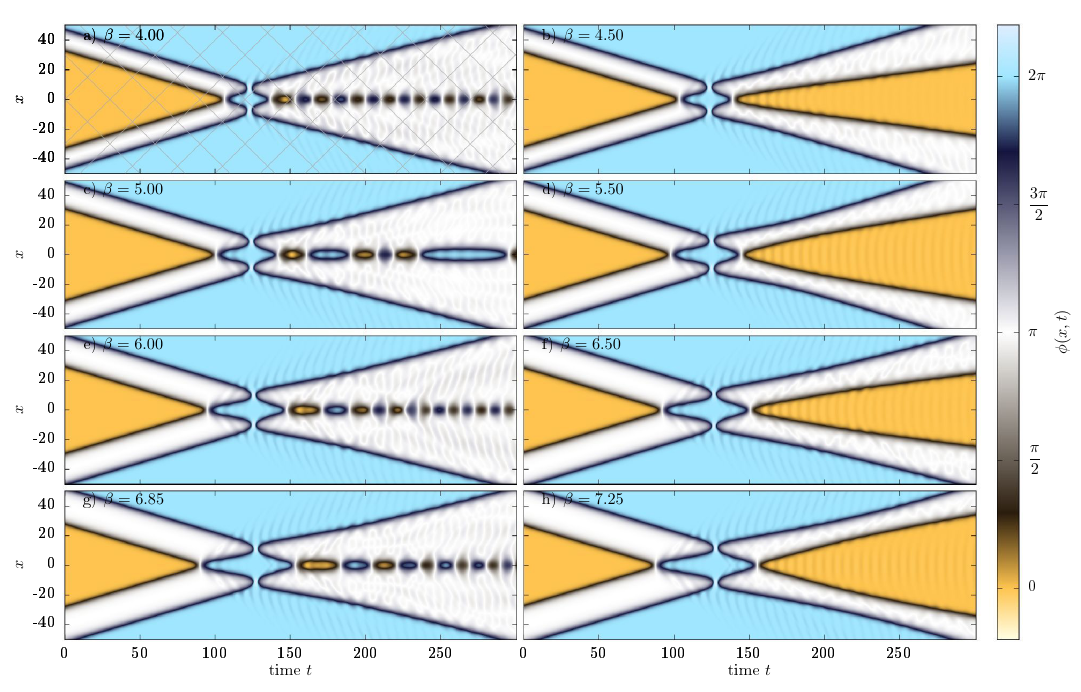
Figure 23 . Example collisions with initial velocity v = 0 . 3 for a variety of values of β , showing the decomposition of the initial collision into four subkink collisions.